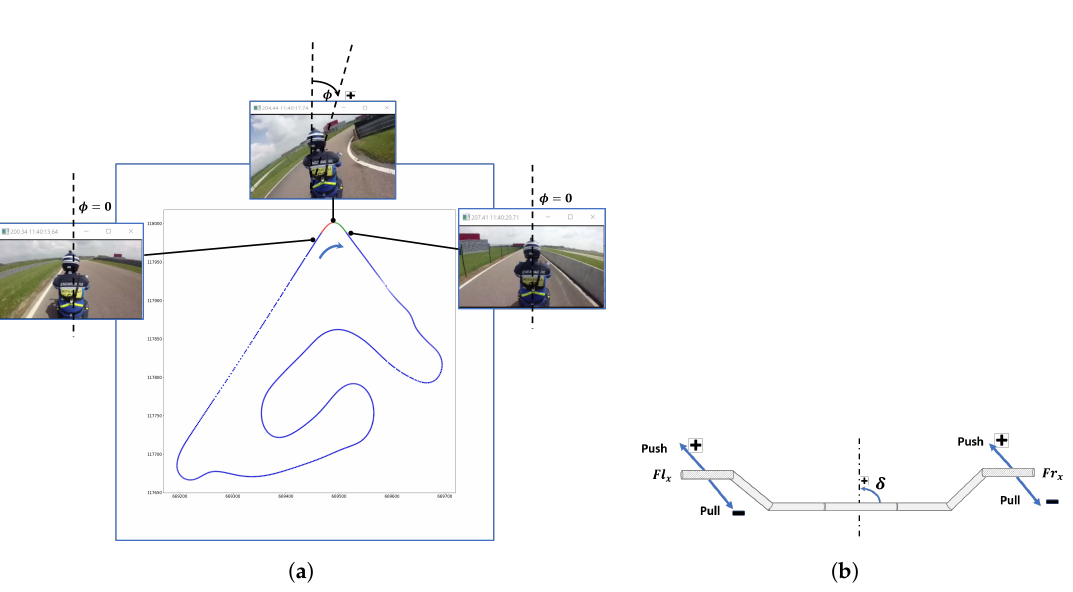
Figure 10. ( a ) Roll ( φ ) and ( b ) steering ( δ ) angles and forces ( fl x , fr x ) applied on the handlebar steering conventions.